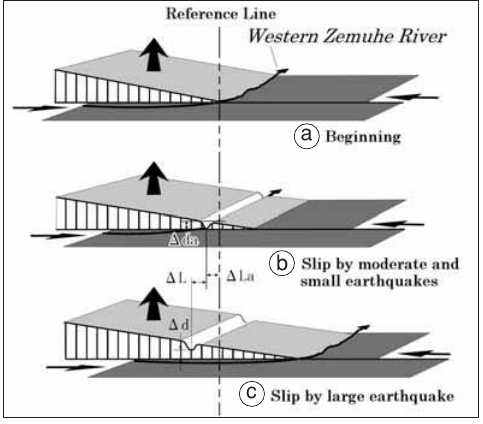
Fig. 12a-c. Model to illustrate the development the Daqingliangzi fault scarp and ravines on the scarp top. (cid:54) . L and (cid:54) d are the horizontal and vertical offsets during large magnitude earthquakes; (cid:54) . La and the depth of the abandoned ravine (cid:54) da are the horizontal and vertical offsets accommodated by moderate and small